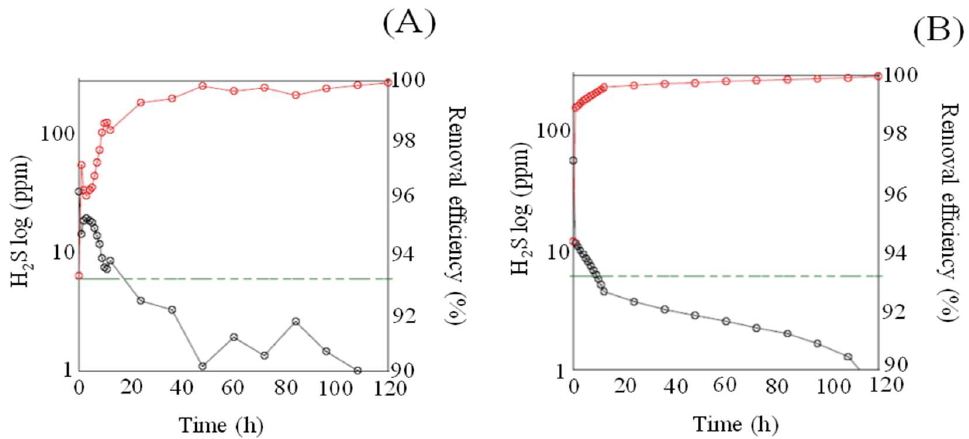
Figure 3. The removal efficiency of H 2 S at inlet concentrations of ( A ) 500 ppmv and ( B ) 1000 ppmv. Red circles: % removal efficiency; black circles: outlet H 2 S concentration.